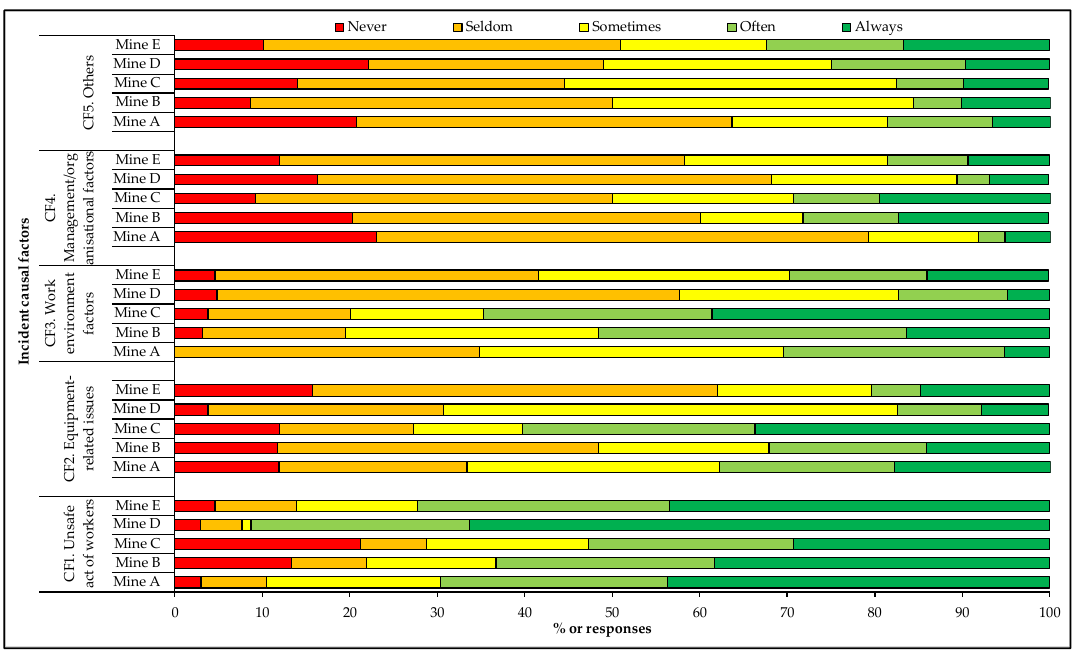
Figure 4. Comparison across mines of how often the survey participants perceived the incident causal factors to be identified during investigations.